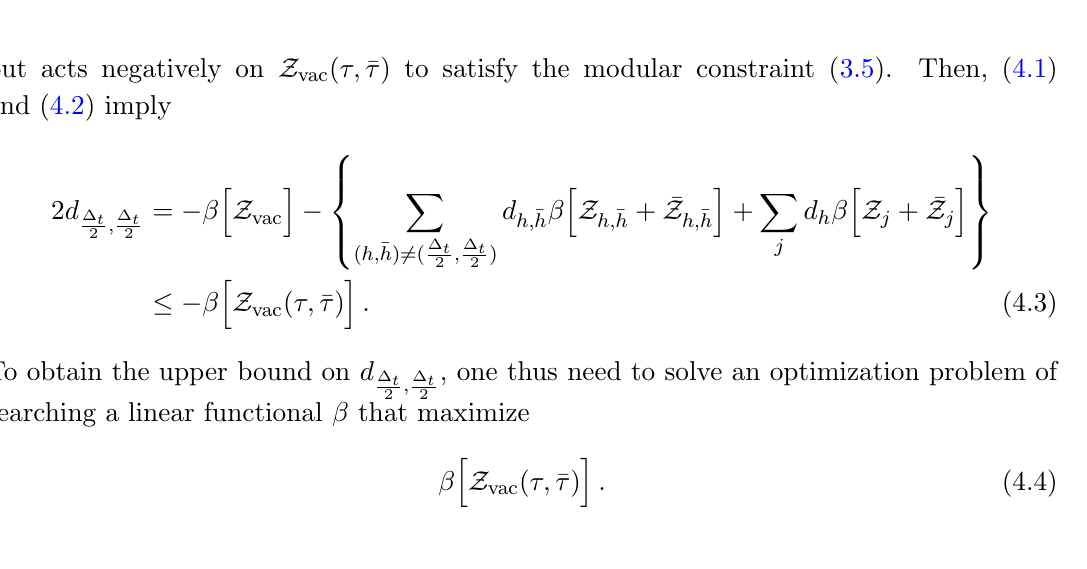
Table 4. List of theories on the numerical boundary of (cid:1) t . We include the conserved currents of j (cid:21) 2 in